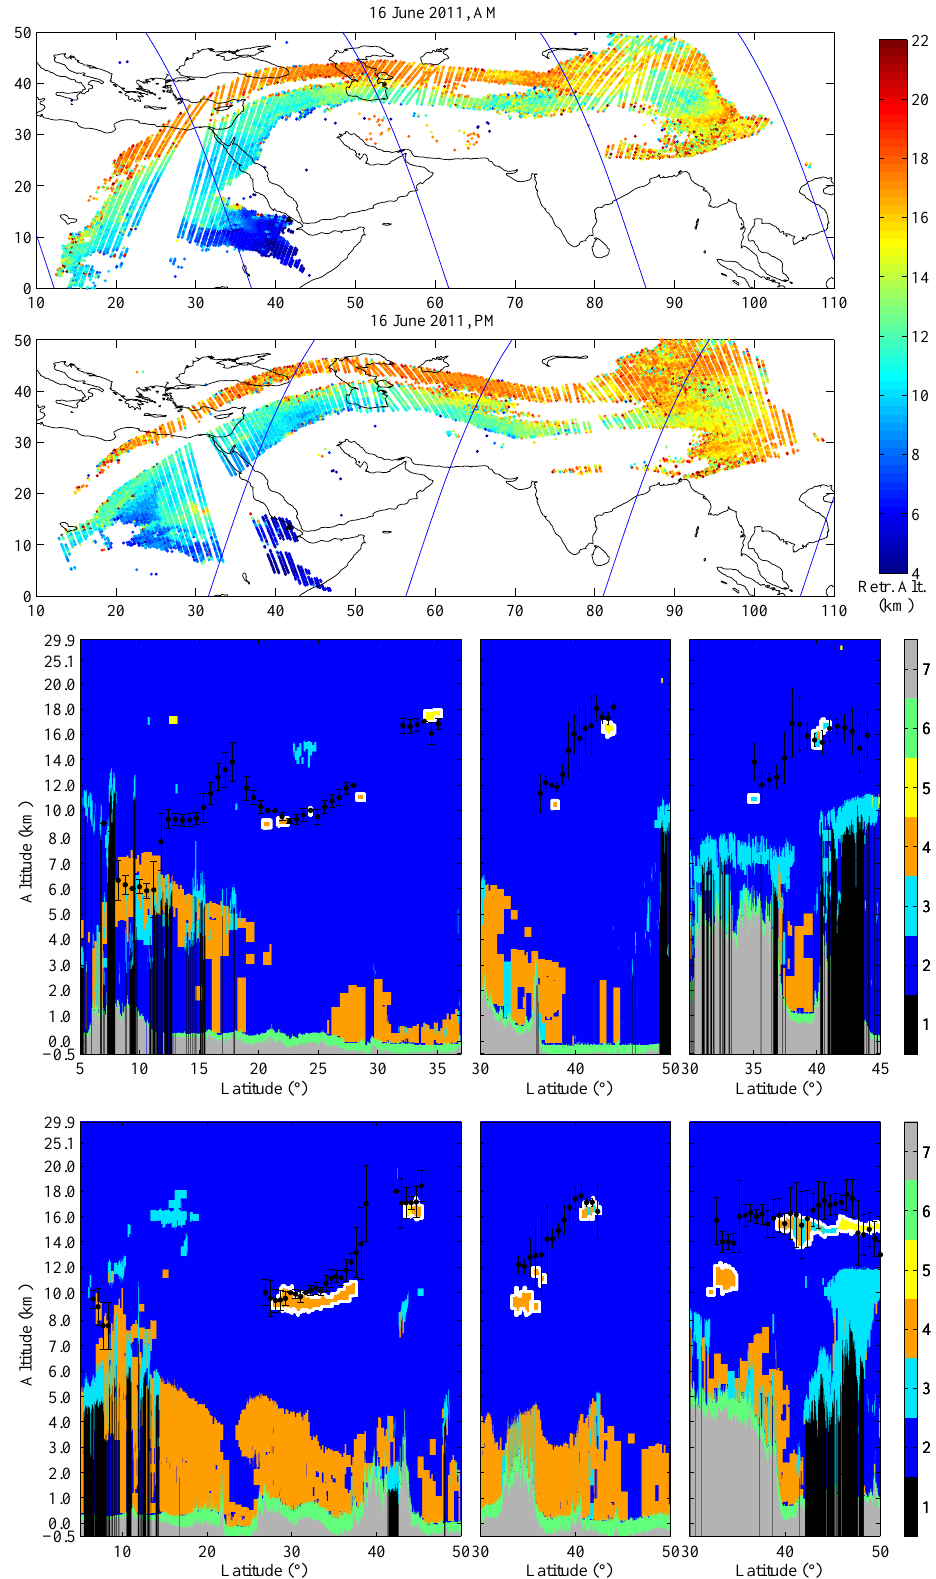
Fig. 7. Same as Fig. 6 for 16 June